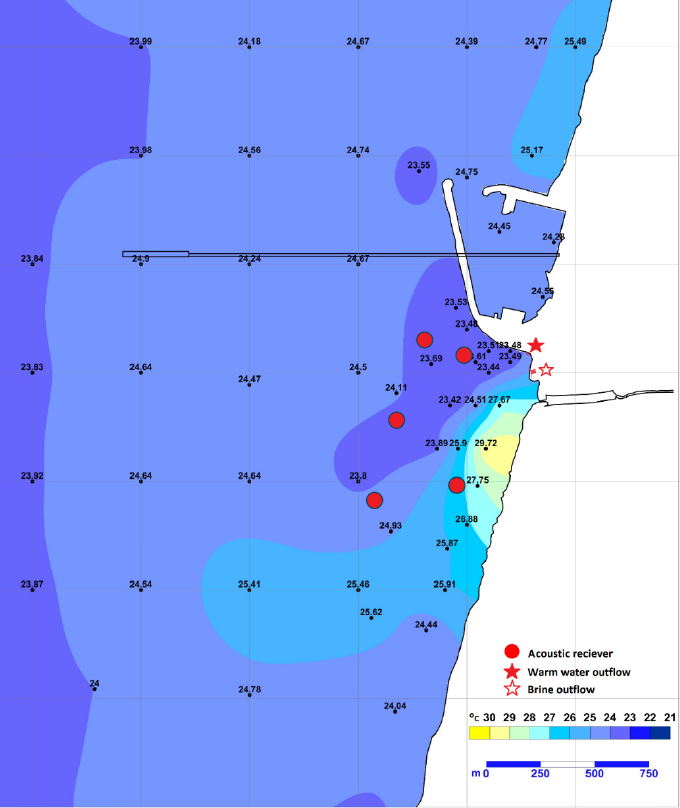
Figure 1. Map of the study site. Temperature is shown as measured by IEC staff on 22 May 2018, at 2 m depth. Circles ( ) represent receiver locations; star ( ) represents the discharge point for warm water and star with no fill ( ) for warm saline water. Adapted from the IEC monitoring report 2018.